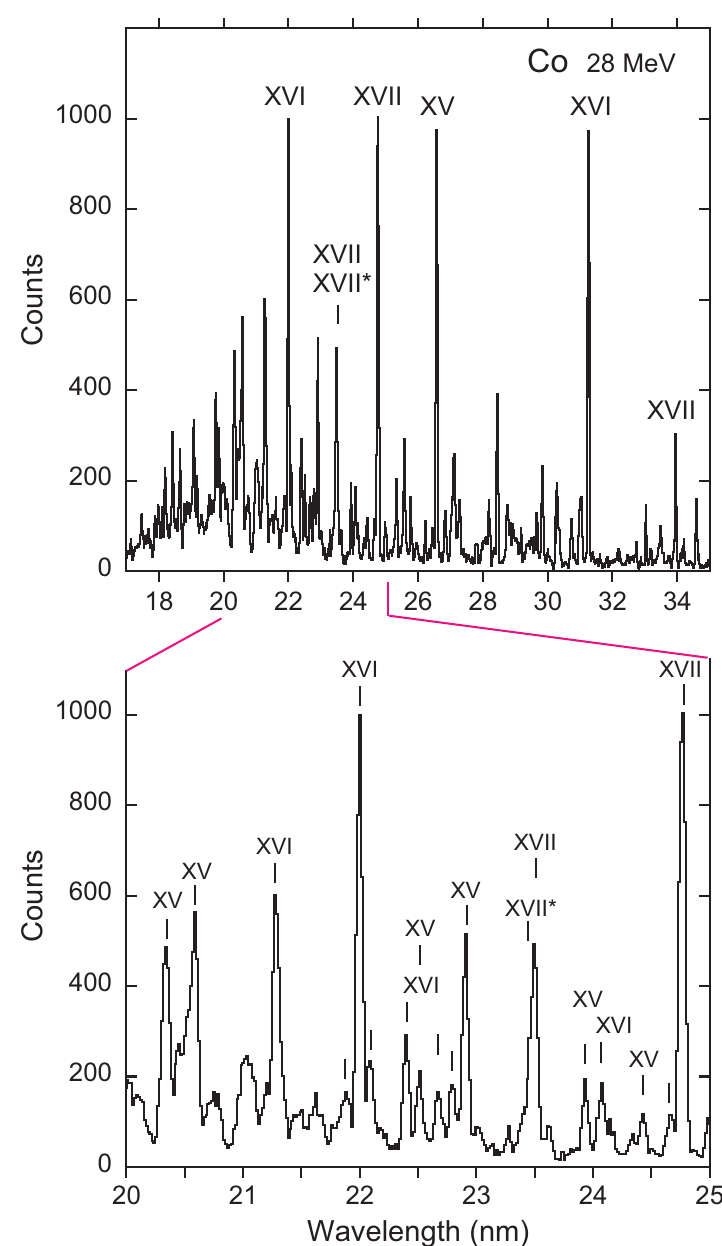
Figure 7. Beam-foil spectrum of 59 Co recorded at an ion beam energy of 28 MeV, somewhat below the optimum ion beam energy of about 40 MeV for the production of the CoXVII spectrum [74]: Line width (FWHM) is 0.06 nm. The more prominent ones among the lines are labeled by the spectrum number [75]. In the upper spectrum, the prominent lines yield a reliable wide-range wavelength calibration. However, the CoXVII* line of present interest lies at λ ≈ 23.4 nm and is part of a blend with a prominent 3p–3d line. The lower part of the figure expands the display of the vicinity of the CoXVII* line and reveals that the line of interest is a minor part of that line